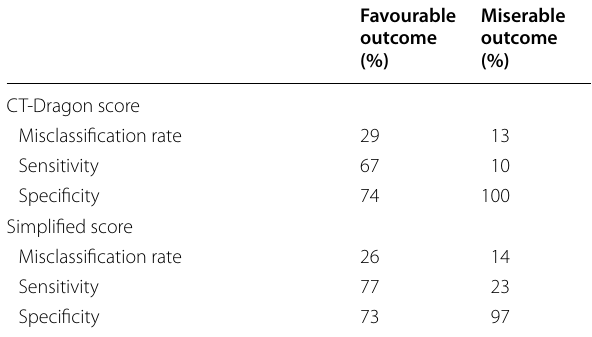
Table 1 Predictive performance of CT‑DRAGON and simplified